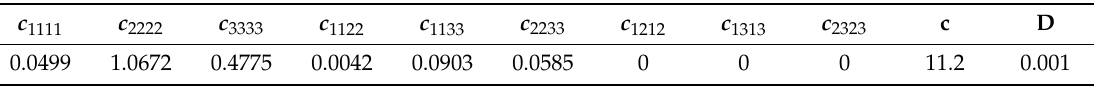
Table 1. Material constants (KPa) for the constitutive relation of Fung-anisotropic model to calculate strain energy